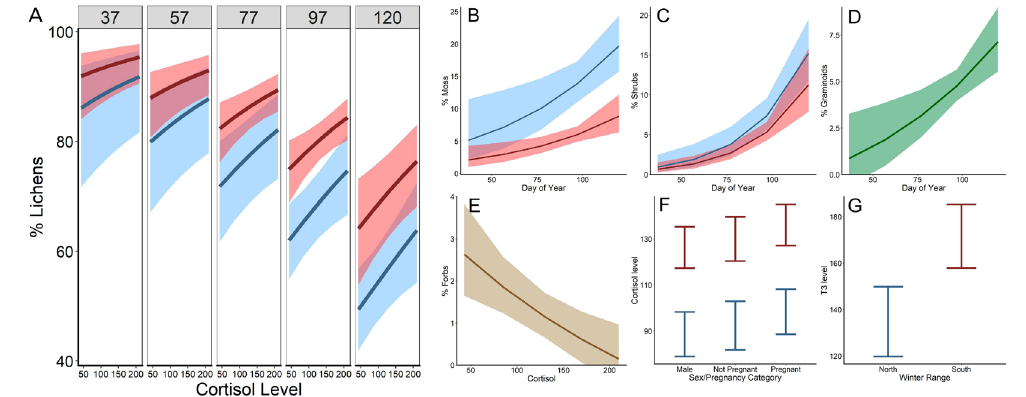
Figure 4. Predicted results from top fitted models in the analysis of winter diet data for caribou in northwest Alaska 2012-2013. Plots are the fitted results from the best performing model for lichen (A), moss (B), shrubs (C), graminiods (D), forbs (E), cortisol level (F) and T3 level (G). When the winter range category was significant, red-shaded lines represent the southern range (south of 67. 1°N) and blue-shaded lines depict the northern range. Bands (A-E) and bars (F and G) depict 95% confidence intervals. For percent lichen (A), sub-plots depict the specified day of year, indicated at the top of each